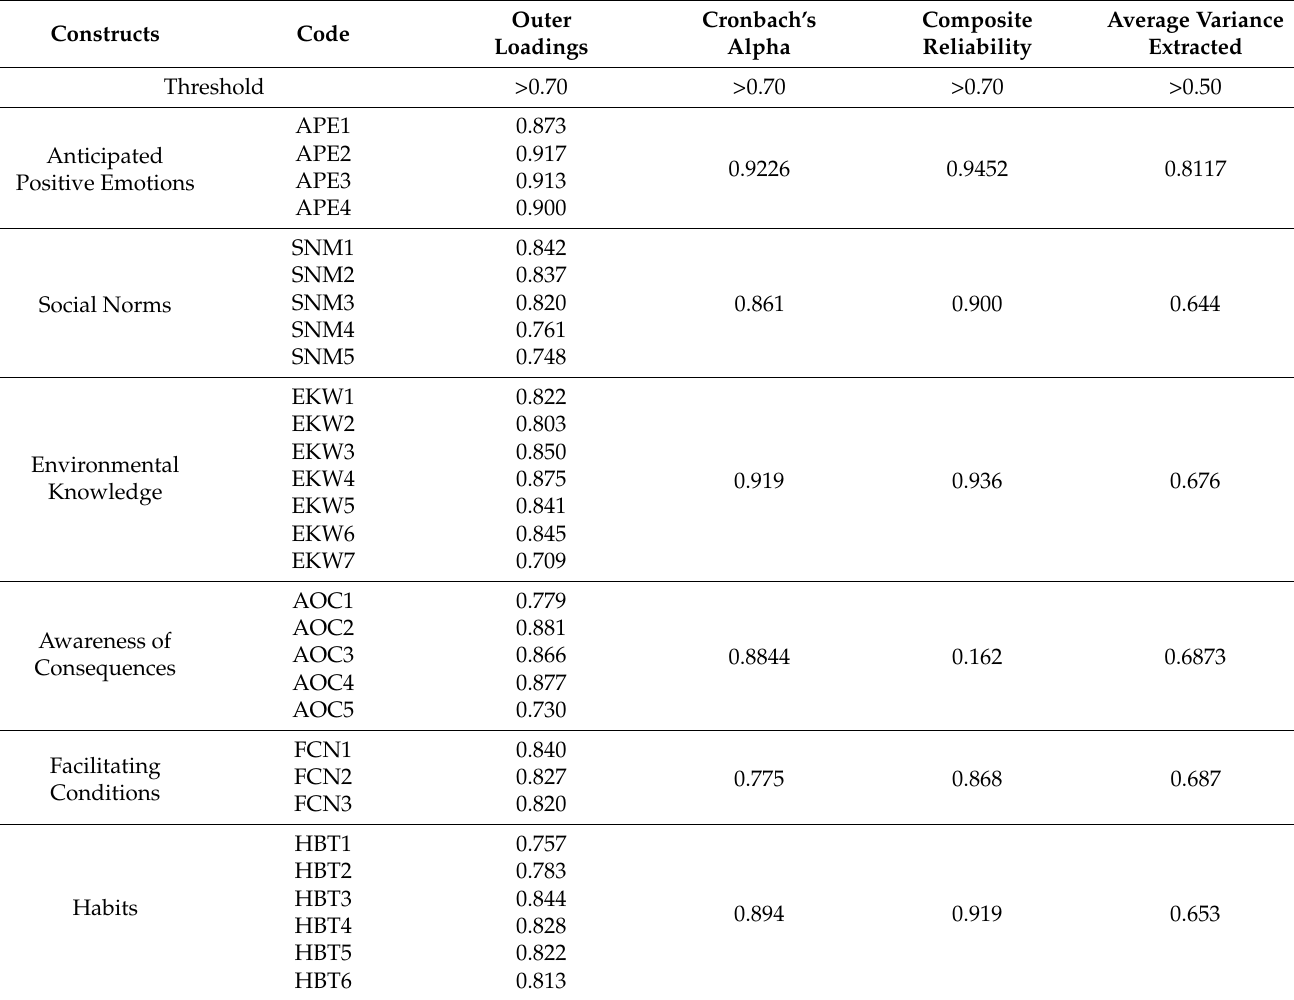
Table 2. Measurement model